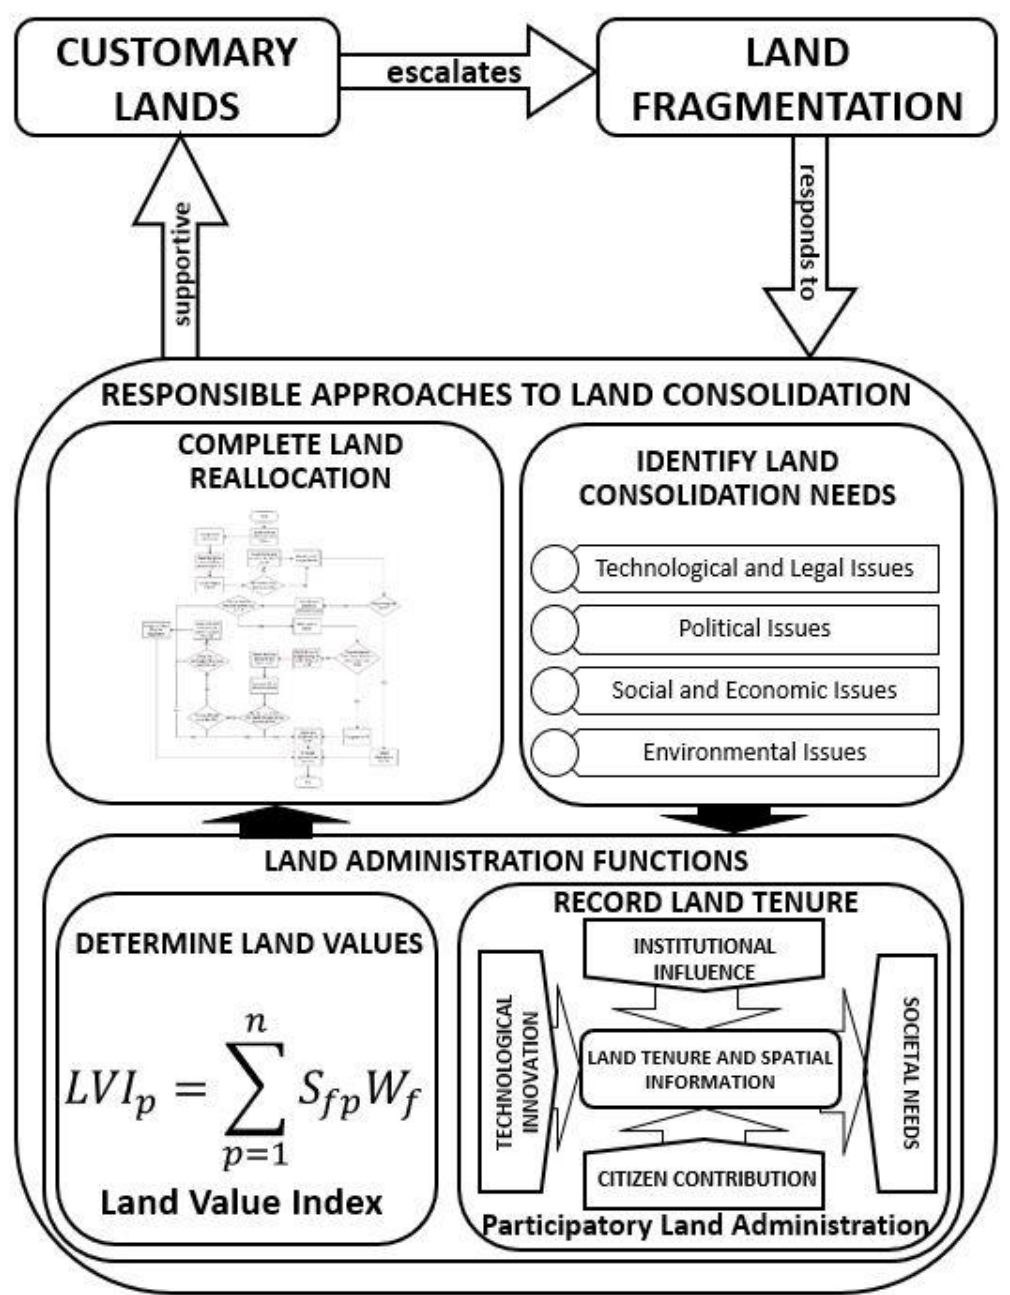
Figure 5. Summary of the results and components of responsible land consolidation.